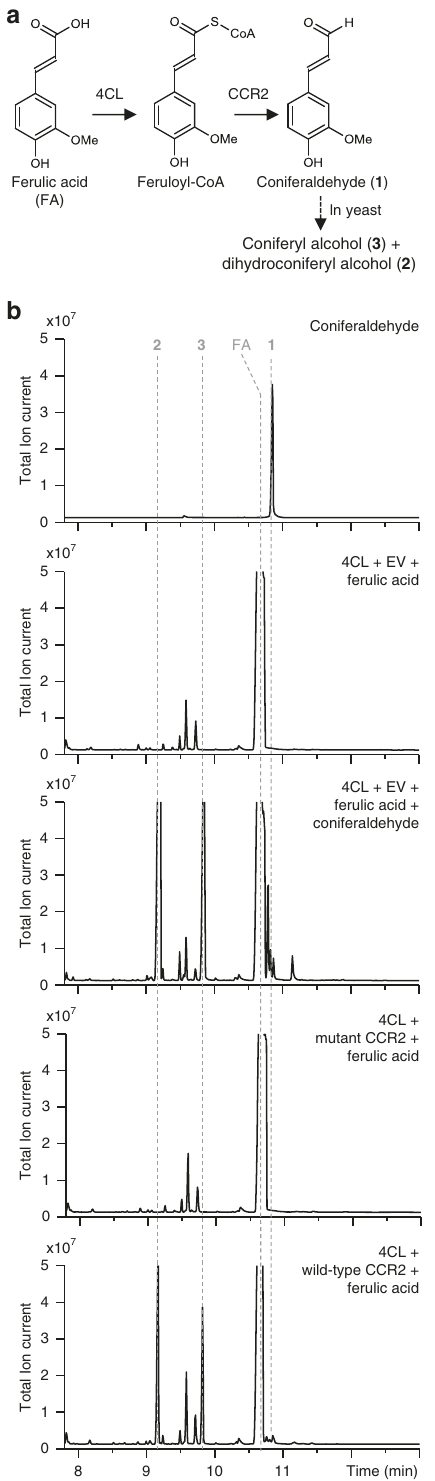
Fig. 8 CCR2 activity assays in yeast. The relative activity of the mutant P. alba CCR2 protein (as present in CCR2 ( − /*) line 12) was determined in yeast. a Principle of the yeast feeding assay. Yeast cultures were engineered to express 4CL and the wild-type P. alba CCR2 protein